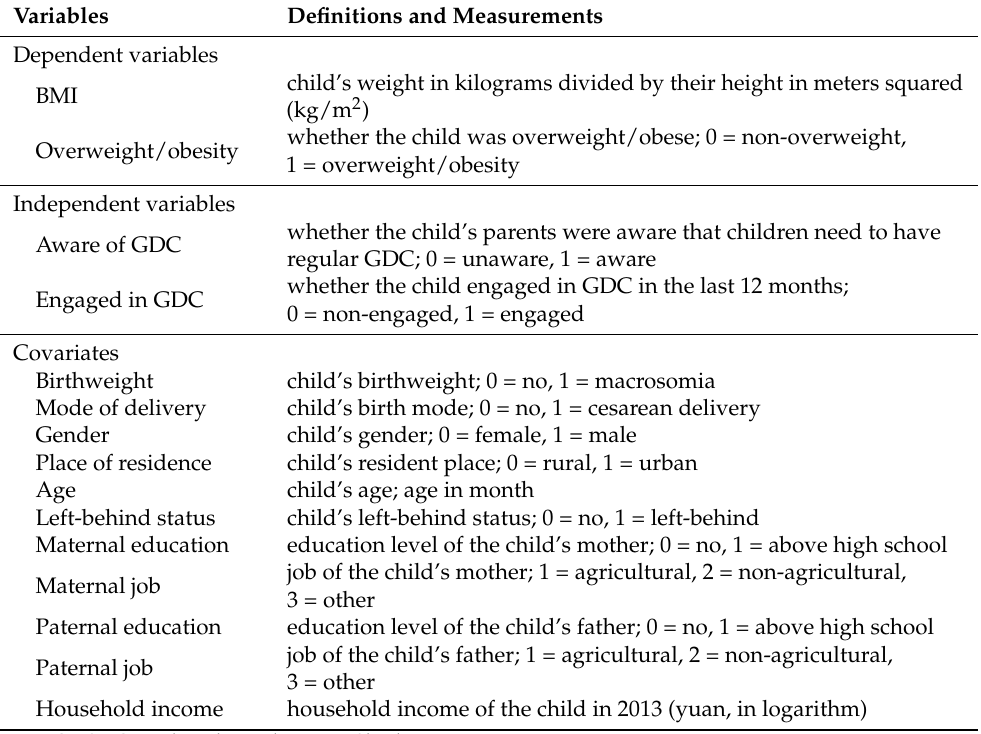
Table 1. Definitions and measurements of